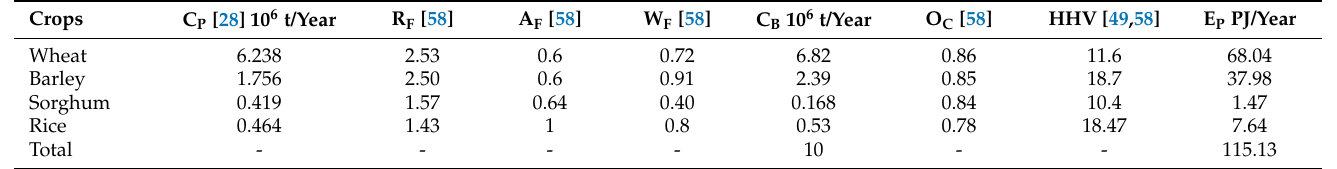
Table 8. The energy potential of different crop residues available in Iraq for